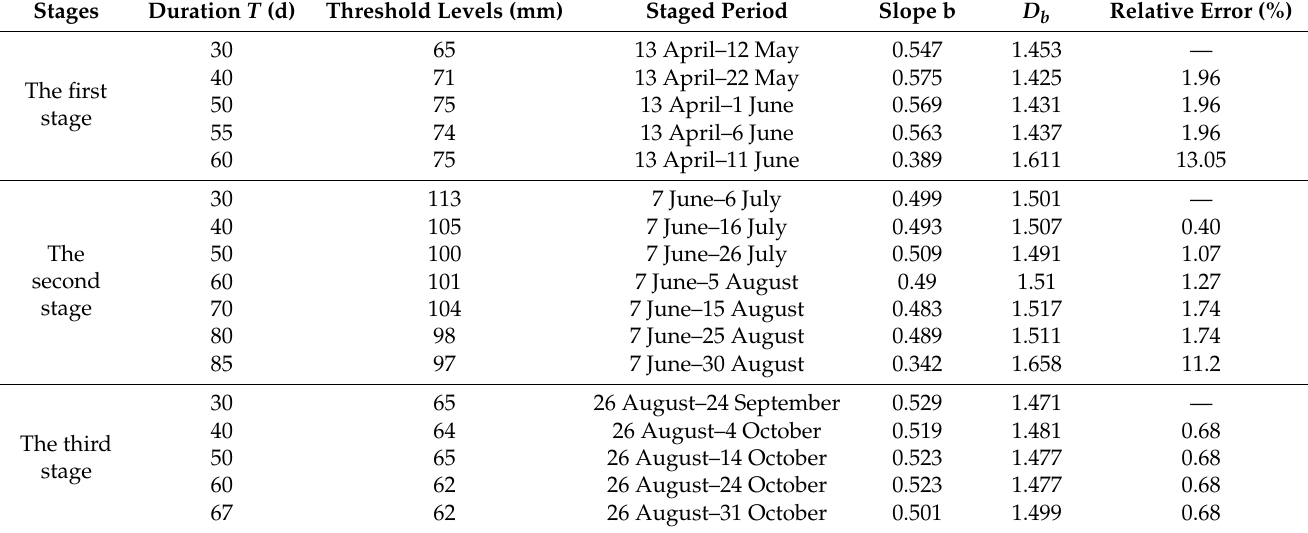
Table 2. Staging results of multi-year average daily rainfall.